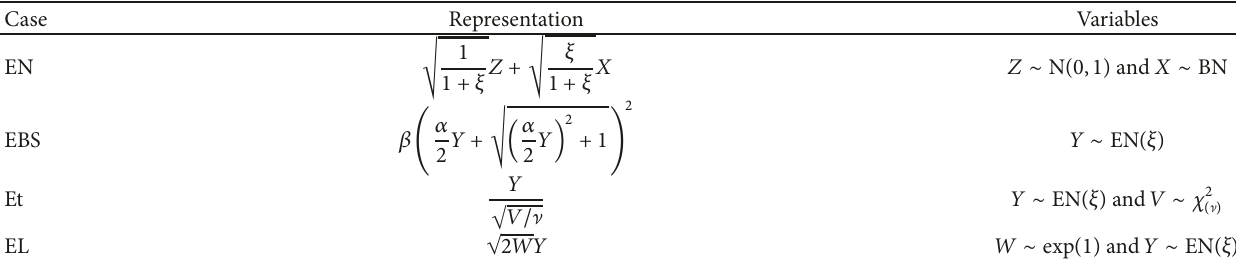
Table 1: Alternative stochastic representation of special